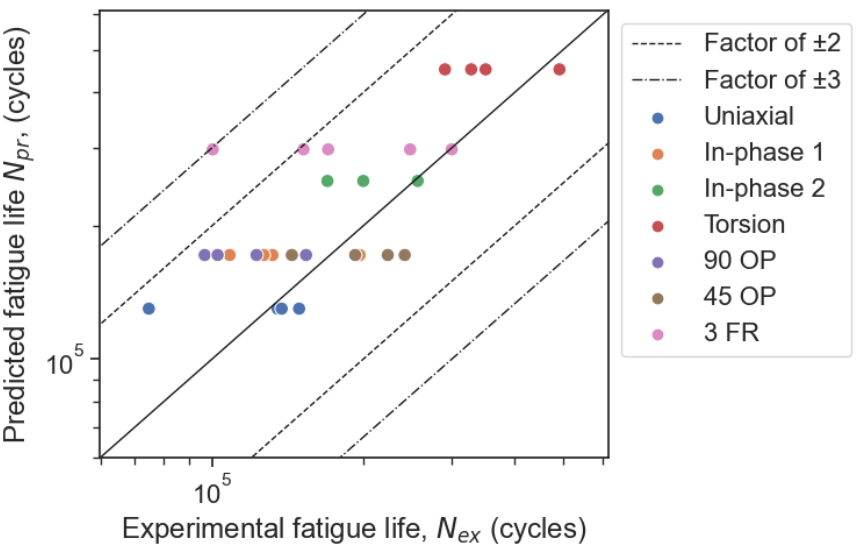
Figure 3: Comparison of model prediction with experimental